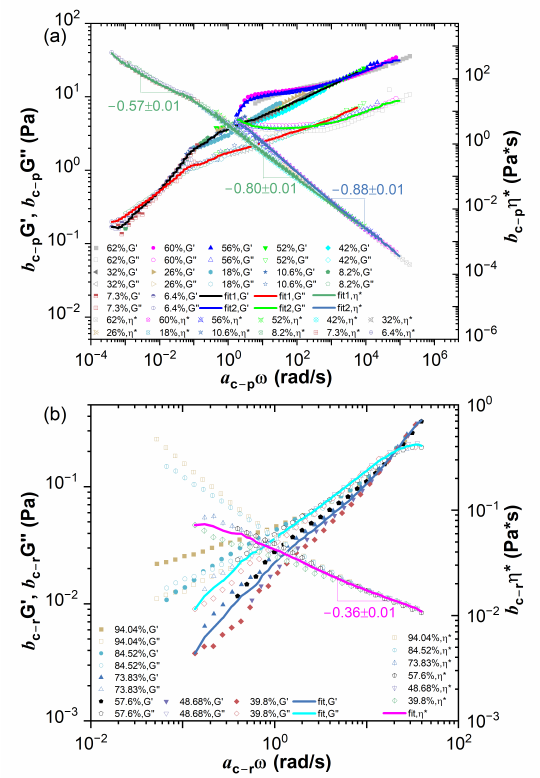
Figure 3. ( a ) The master curve of Phormidium suspension with φ ref = 18%, ( b ) the master curve of blood with φ href = 57.6%. The subscript of the shifting factors p represents Phormidium suspension, r represents human blood with RBC. The fitted master curves are shown in the